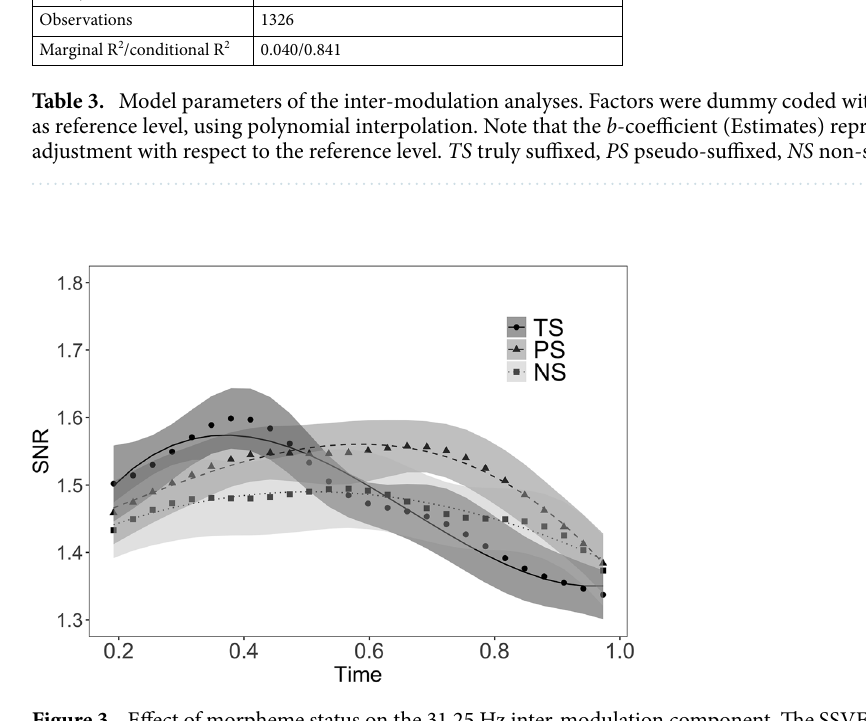
Figure 3. Effect of morpheme status on the 31.25 Hz inter-modulation component. The SSVEP time course from RESS component optimized for 31.25 Hz is shown. Symbols represent EEG data; shadows represent standard error of the means (SEMs) adjusted to correctly reflect the variance in the within-subject design (Morey, 2008). Lines represent growth curve analysis model fit. TS = Truly suffixed, PS = Pseudo-suffixed, NS = Non-suffixed. The figure was created using R 56 (http:// www.R- proje ct. org) package ggplot2 (https:// cran.r- proje ct. org/ web/ packa ges/ ggplo t2/ index.